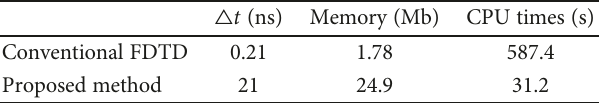
Figure 2: Comparison of the magnetic fi elds calculated by proposed method and conventional FDTD at two observation points. Table 1: Comparison of the computational